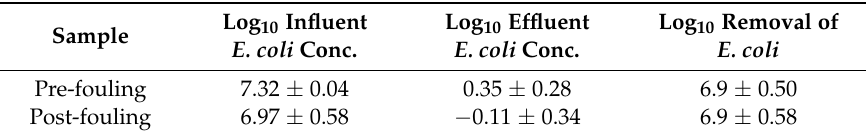
Table 5. Change in log 10 removal after 96 h, with two lamps on, a 0.16 L/s flow rate, and CaCl 2 and Na 2 CO 3 feed